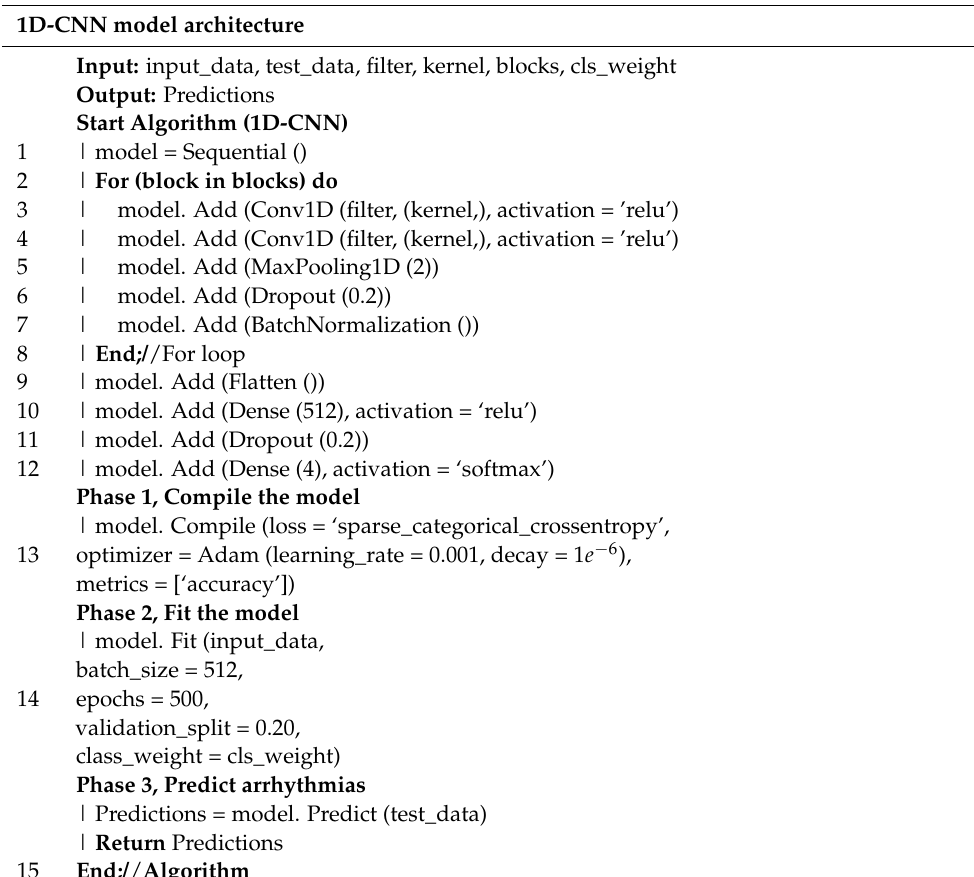
Algorithm 1. The 1D-CNN